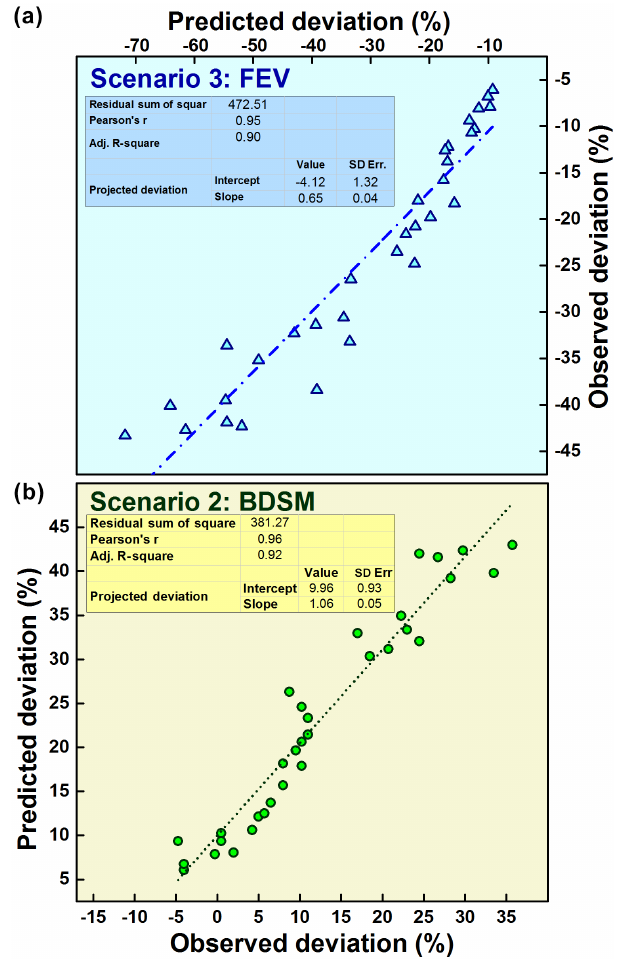
Figure 3. Deviation of the observed soil organic carbon values from the hypothetically estimated values in different methods of soil fer- tility estimation, where (a) is based on FEV (fine earth volume, Sce- nario 3) and (b) is based on BDSM (bulk-density-based soil mass, Scenario 2).